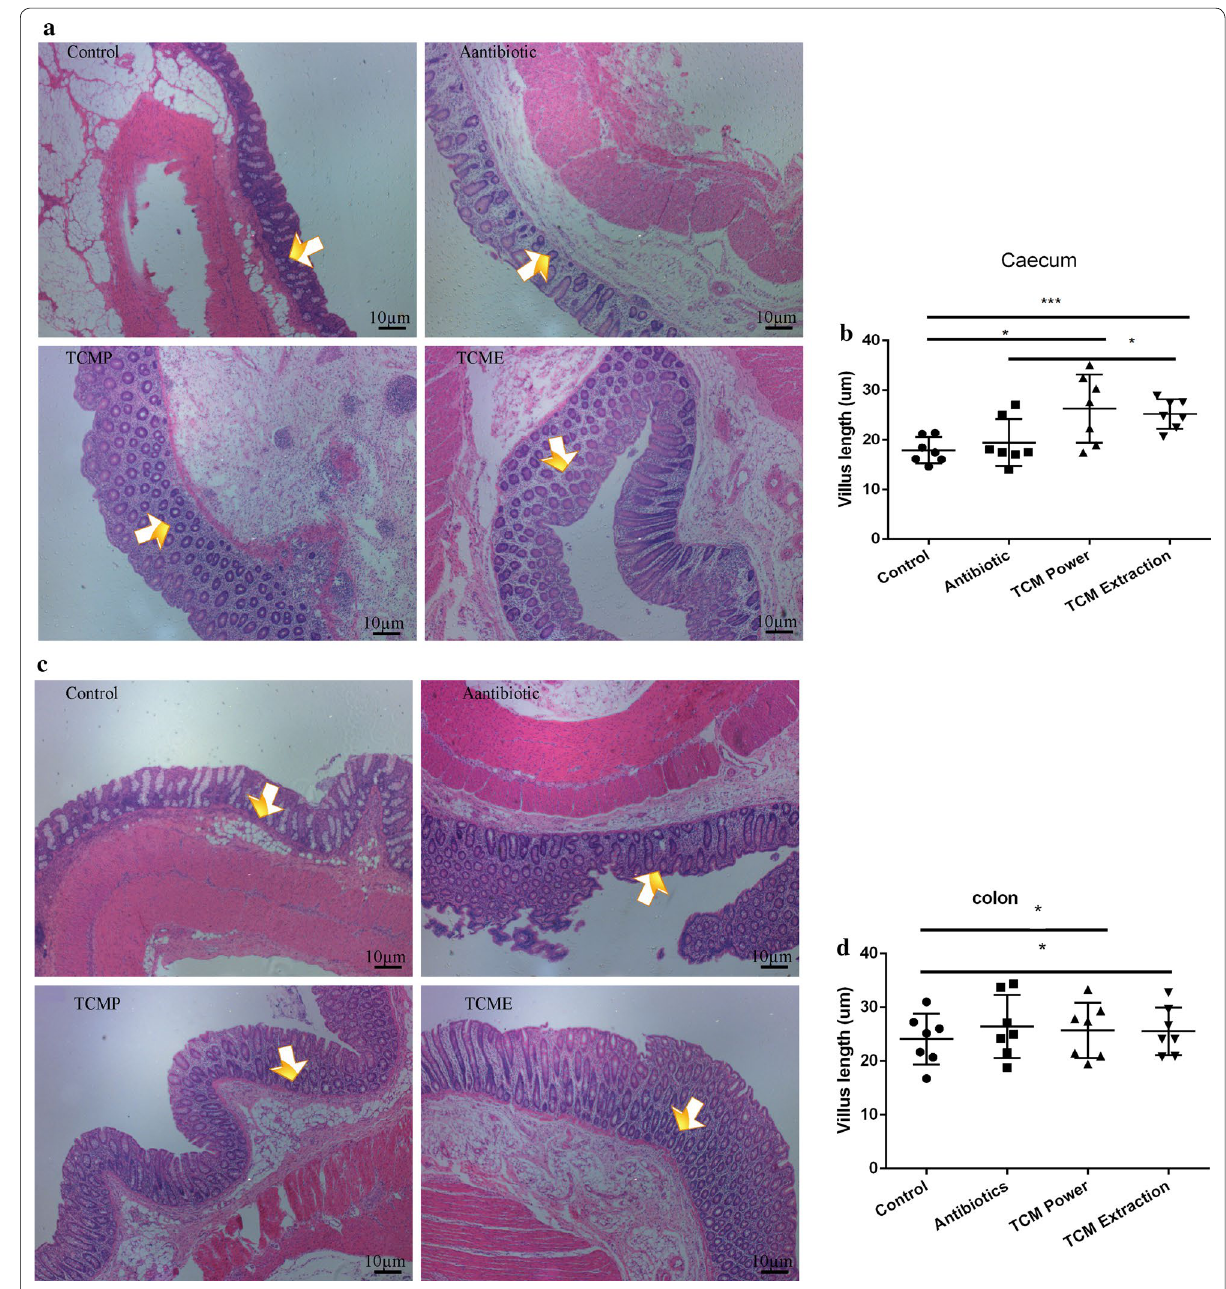
Fig. 4 Morphological changes in the cecal and colonic villi of weaned pigs. a Morphological changes in the ceca of weaned pigs; b Length of the cecal villi. c Morphological changes in the colons of weaned pigs. d Length of colonic villi in different groups. (* p < 0.05; *** p <